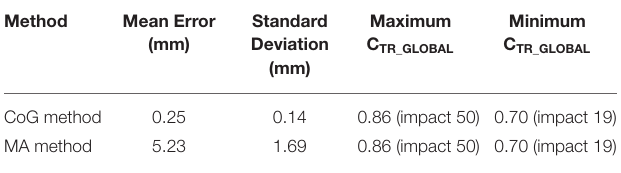
TABLE 2 | Post processing results for grid refinement, CoG method and the new topological approach.